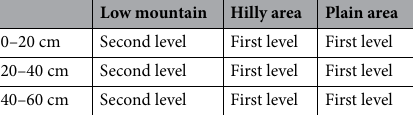
Table 2. Soil environmental quality level of the each depth of the each geomorphic unit.